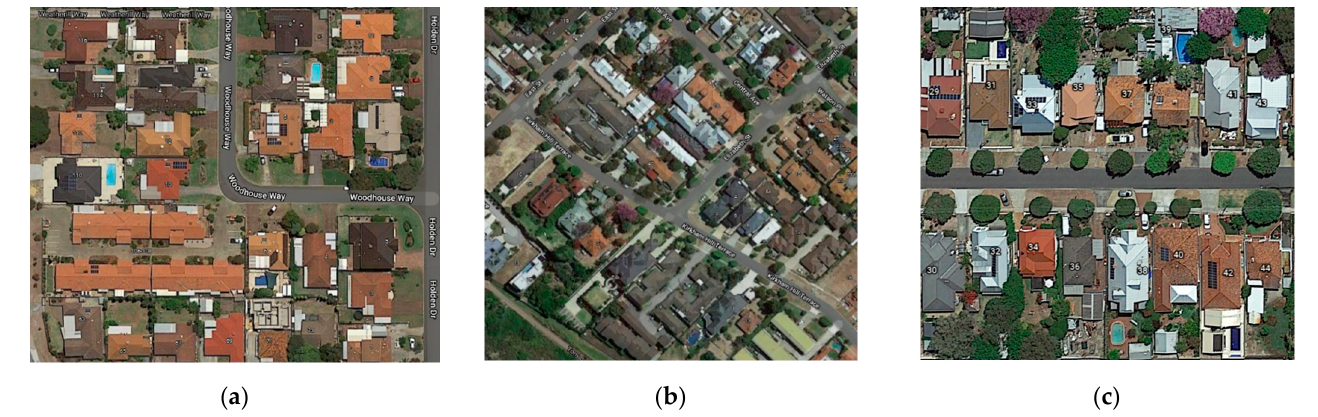
Figure 3. ( a ) Example of housing in Noranda (northern section); ( b ) example of housing within Maylands (southern section); ( c ) example of housing in Bayswater (southern section) (collected from Google Maps). Table 1. Demographic information of areas within the City of Bayswater [35–37].